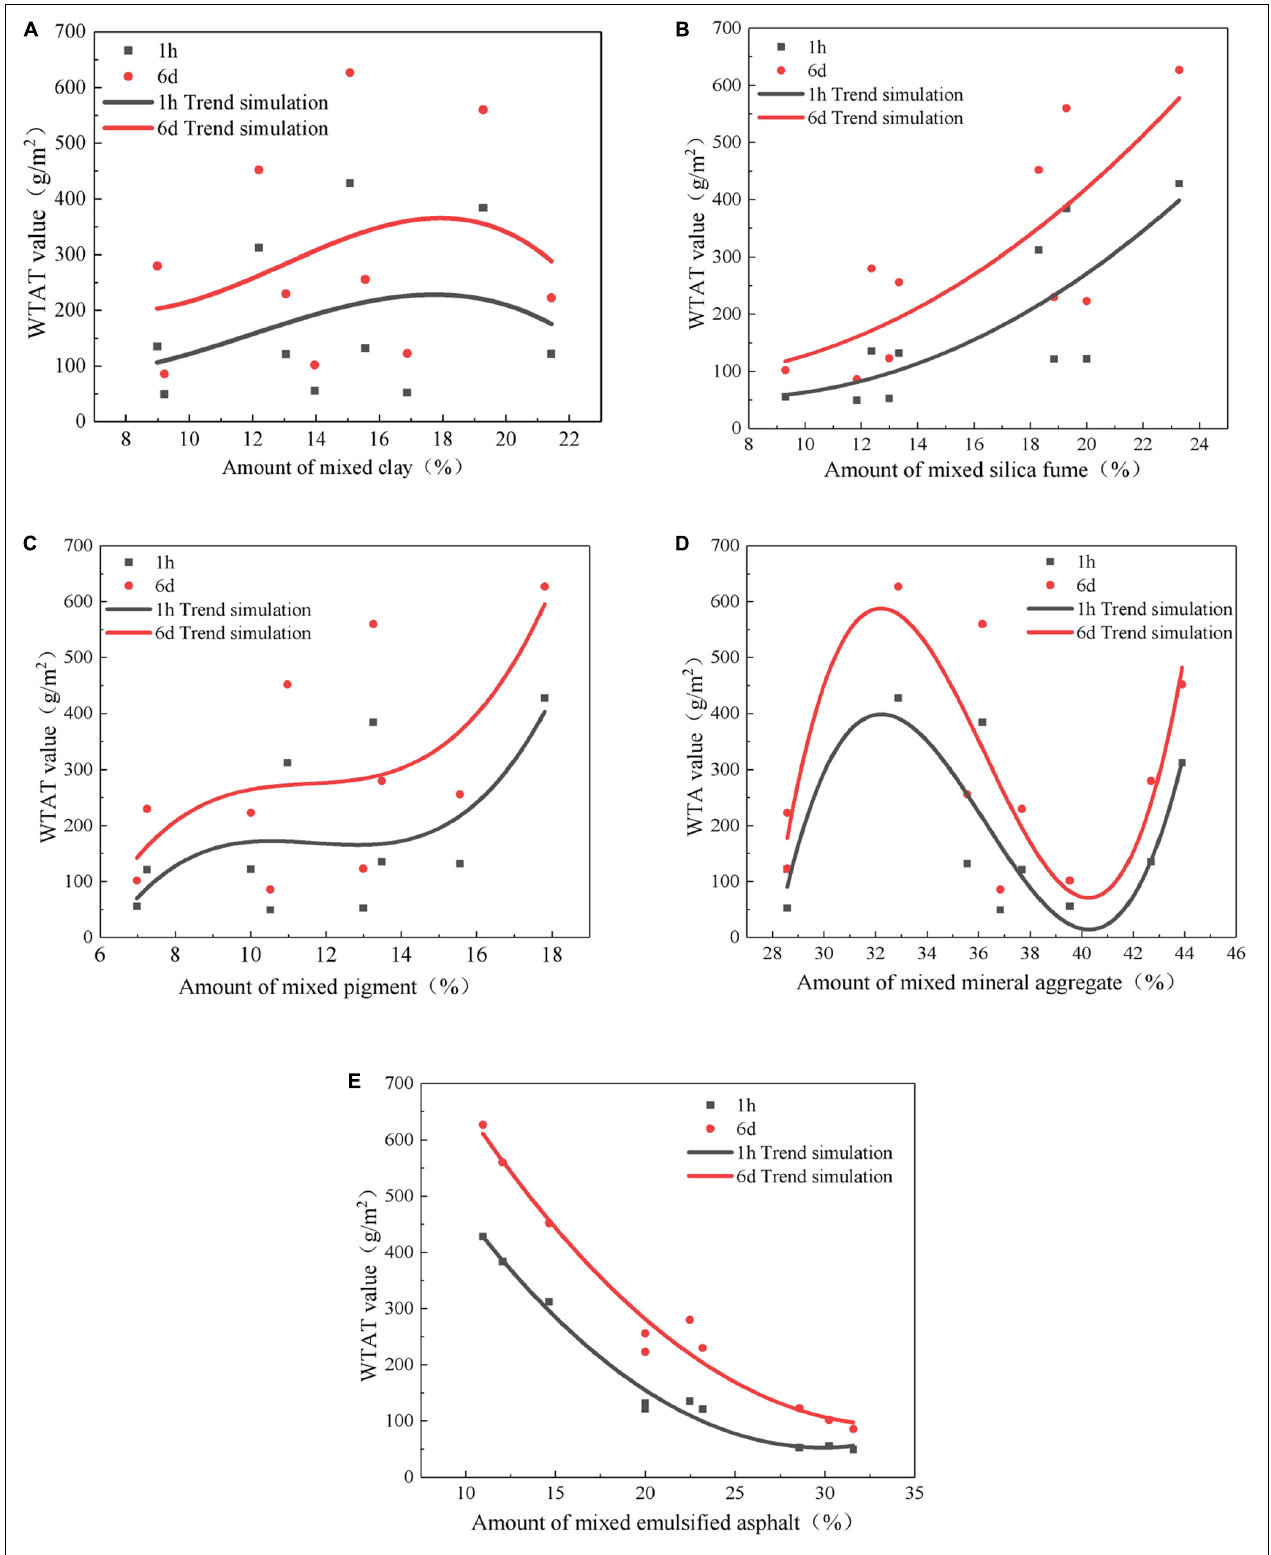
FIGURE 3 | Effects of different test factors on the WTAT value of the mixtures. (A) Amount of mixed clay. (B) Amount of mixed silica fume. (C) Amount of mixed pigment. (D) Amount of mixed mineral aggregate. (E) Amount of mixed emulsified asphalt.